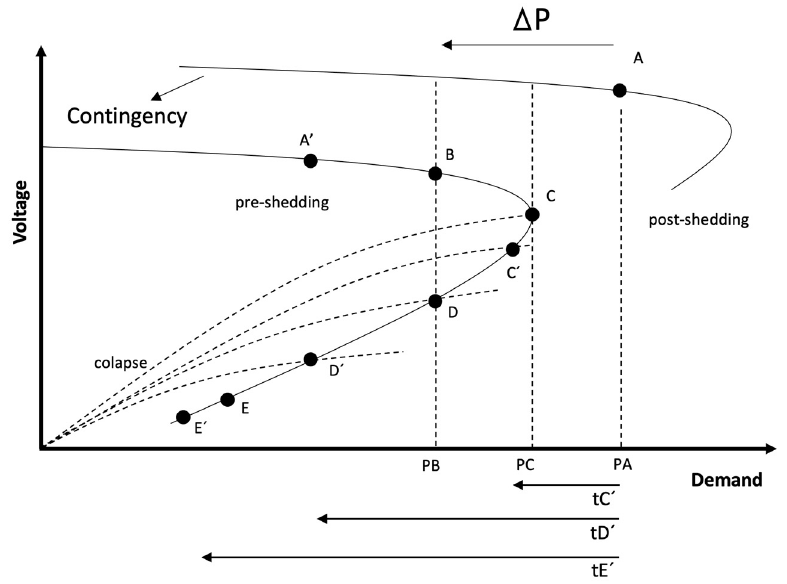
Figure 1. Load shedding effect after a contingency